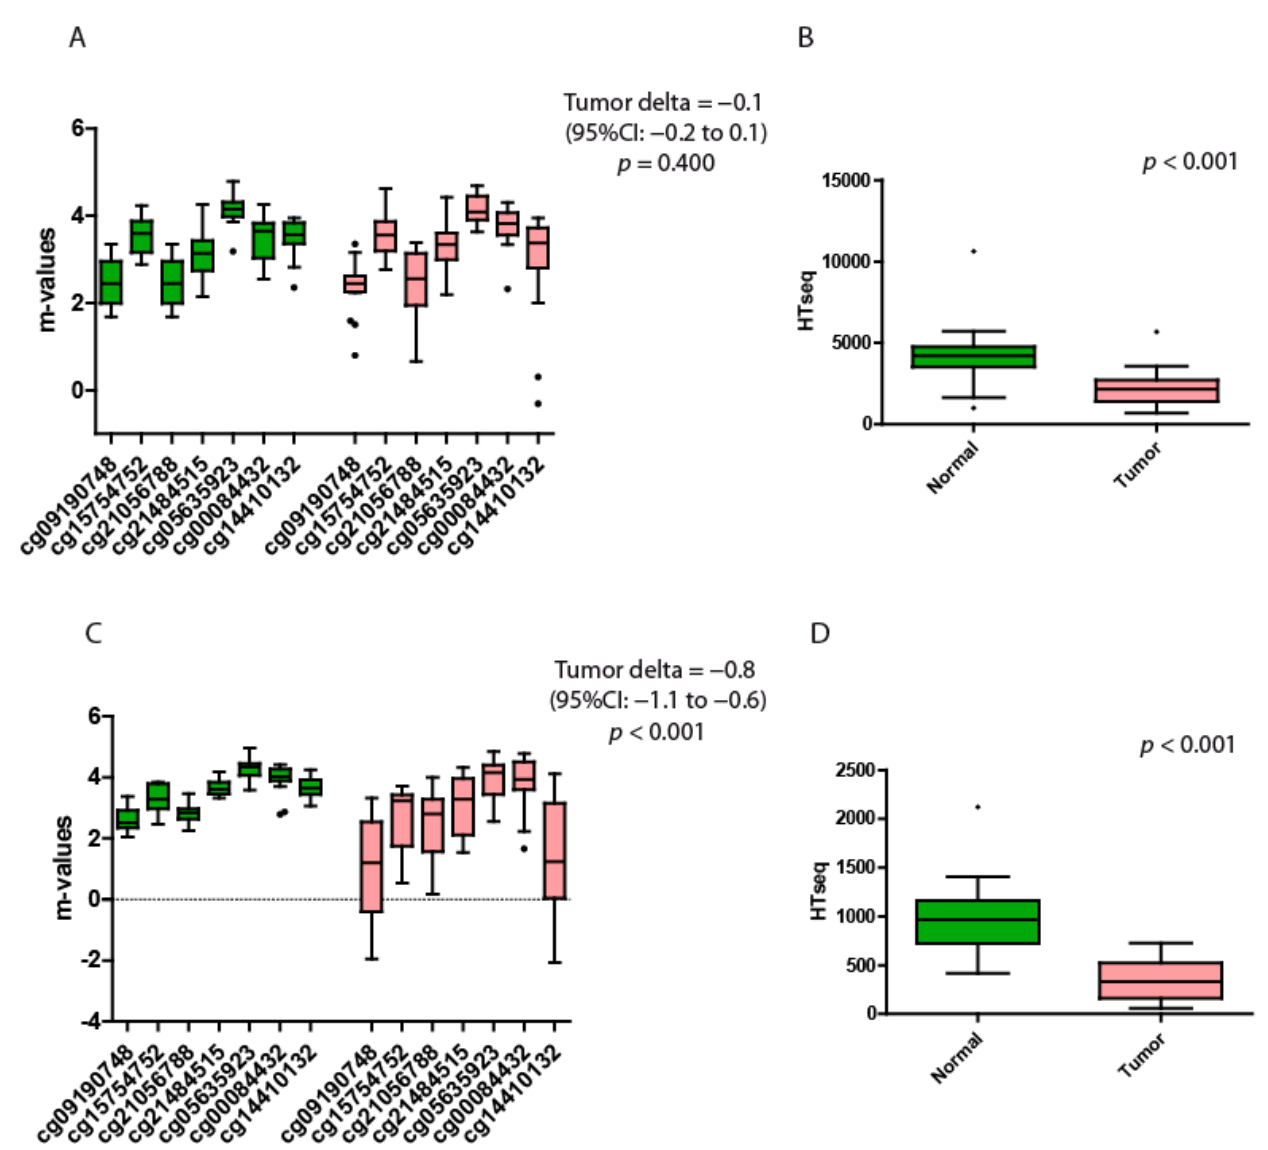
Figure 2. Quantitative methylation and gene expression analysis of bladder and colorectal datasets. ( A ) Bladder m-values of the 7 probes located at the open sea region of the locus SPG20. ( B ) Bladder expression levels of SPG20 in normal versus tumor tissues. The p -value indicates the statistical significance of the data. ( C ) Colorectal m-values of the 7 probes located at the open sea region of the locus SPG20. ( D ) Colorectal expression levels of SPG20 in normal versus tumor tissues. The p -value indicates the significance of the data. Green boxplots represent the nontumoral tissues (solid tissue normal datasets), while red boxplots represent the tumor tissues. The black dots represent the outliers. Each probe is identified with a specific alphanumeric code. The tumor delta is a value that represents the variation between the two groups. The higher the value of tumor delta, the greater the variation between the two groups. Each box plot displays the median value, and the whiskers are the interval between the 1st and 3rd quartiles.